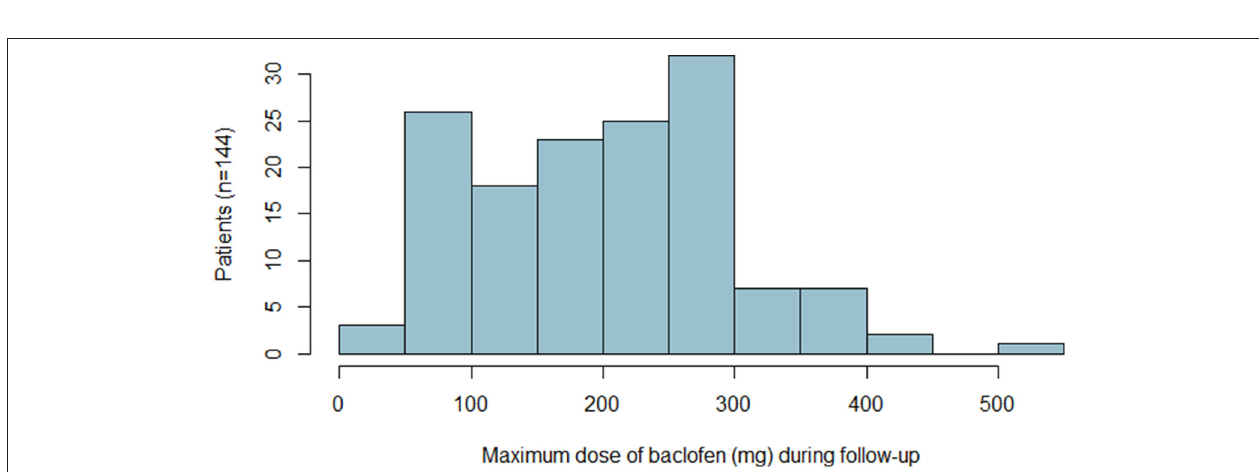
FIGURE 2 | Maximum dose of baclofen taken by patients with the number of patients.